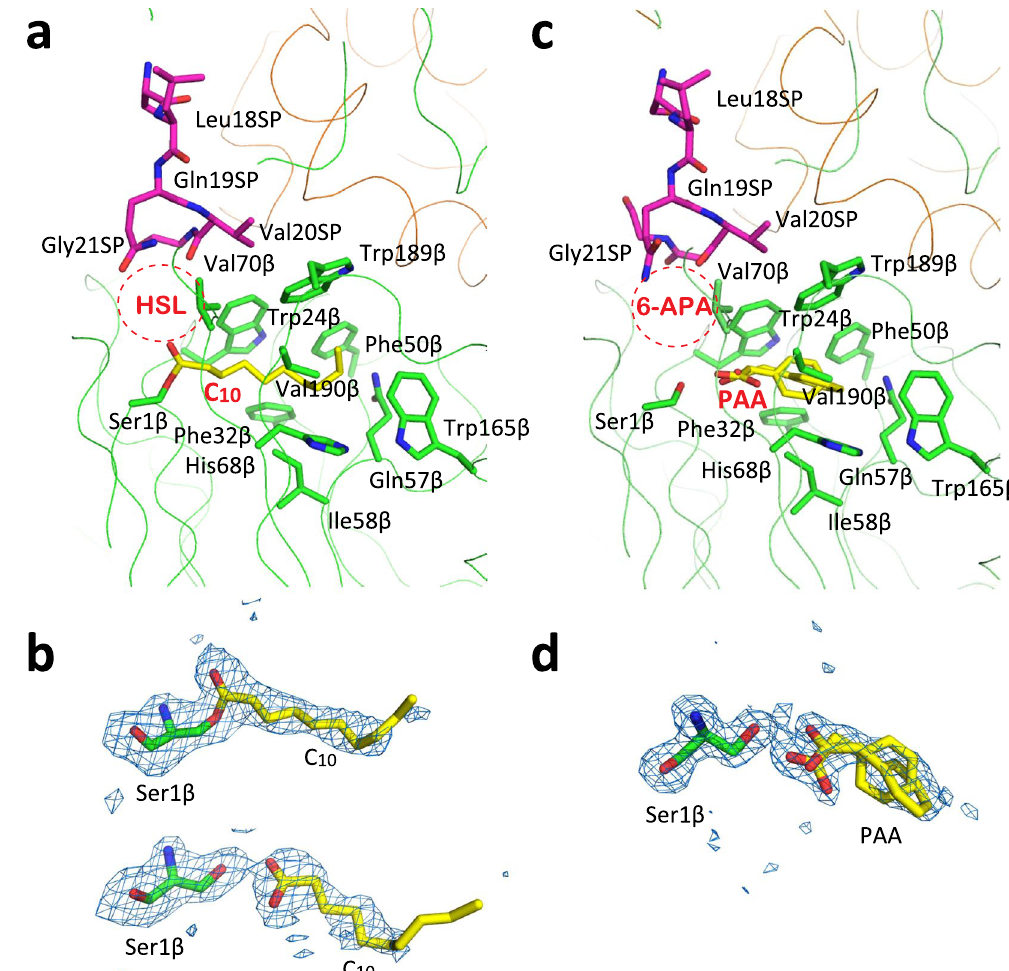
Figure 4. Active site structure of MacQ. The colour scheme is similar to that in Fig. 2b. ( a ) Bound C 10 fatty acid covalently linked to the Ser1 β . The side-chains of nearby residues created the hydrophobic C 10 -binding pocket are also shown and labelled. The expected binding position of HSL moiety is roughly indicated as a red dotted circle. The residues of the SP near the active site are also shown as stick models and labelled. ( b ) m Fo- D Fc omit map for the bound C 10 and the Ser1 β contoured at 2.5 σ level. Two binding states of C 10 were observed: the covalently linked C 10 to O γ of Ser1 β (upper) and the noncovalently bound C 10 (lower). ( c ) Bound PAA. The expected binding position of 6-APA moiety is roughly indicated as a red dotted circle. ( d ) m Fo- D Fc omit map for the bound PAA and the Ser1 β contoured at 2.5 σ level. Two PAA molecules modelled with slightly different positions and conformations fit well onto the observed electron density